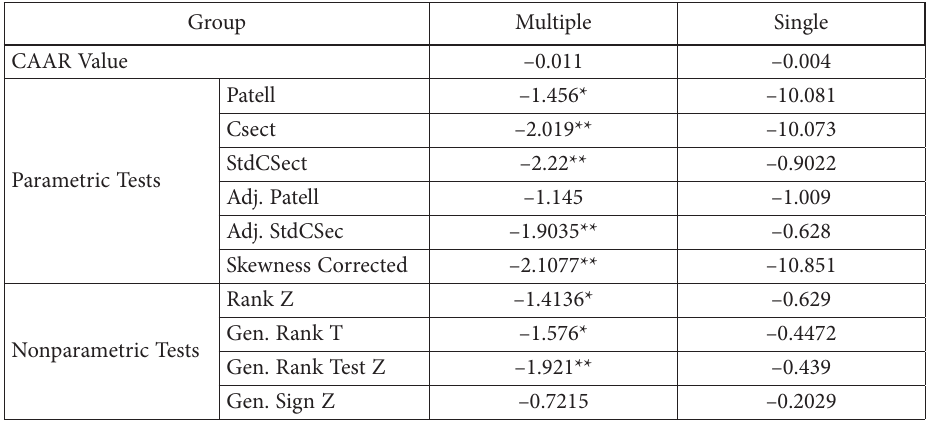
Table 4. Results of grouping the announcements by day (source: own design)